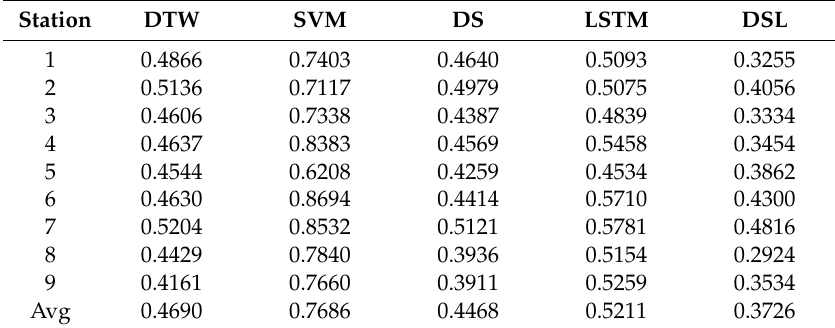
Table 4. RMSE obtained when predicting SST by DTW, SVM, DS, LSTM and